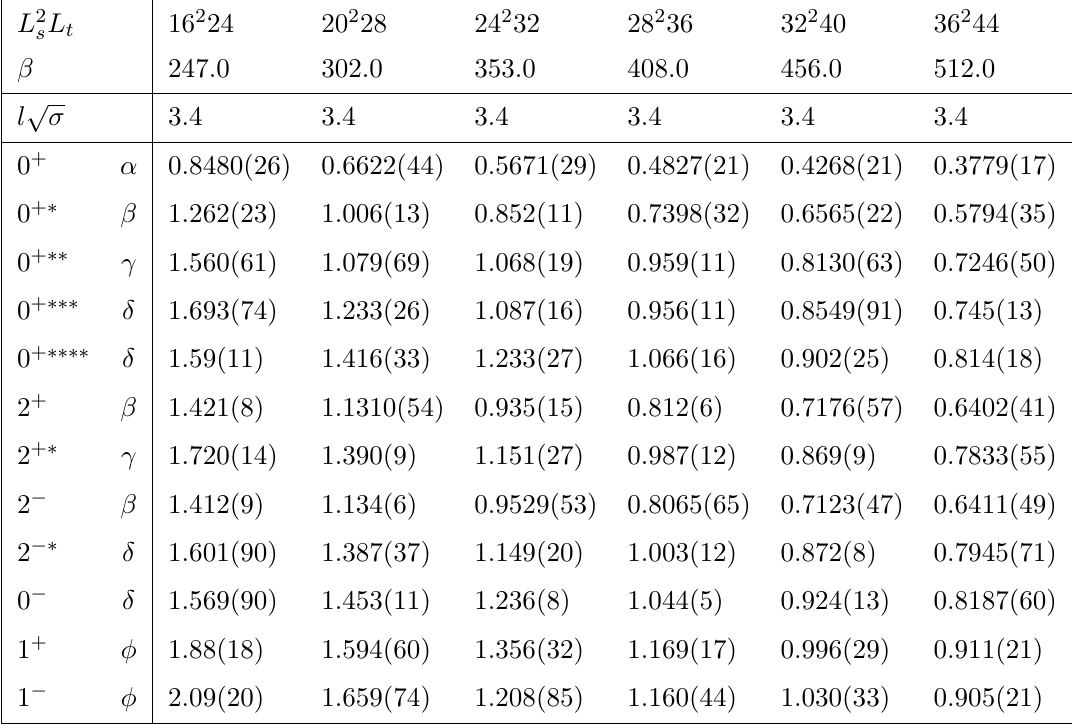
Table 27 . SO(16) glueball masses am G . Grades, e.g. (cid:11) , explained in section